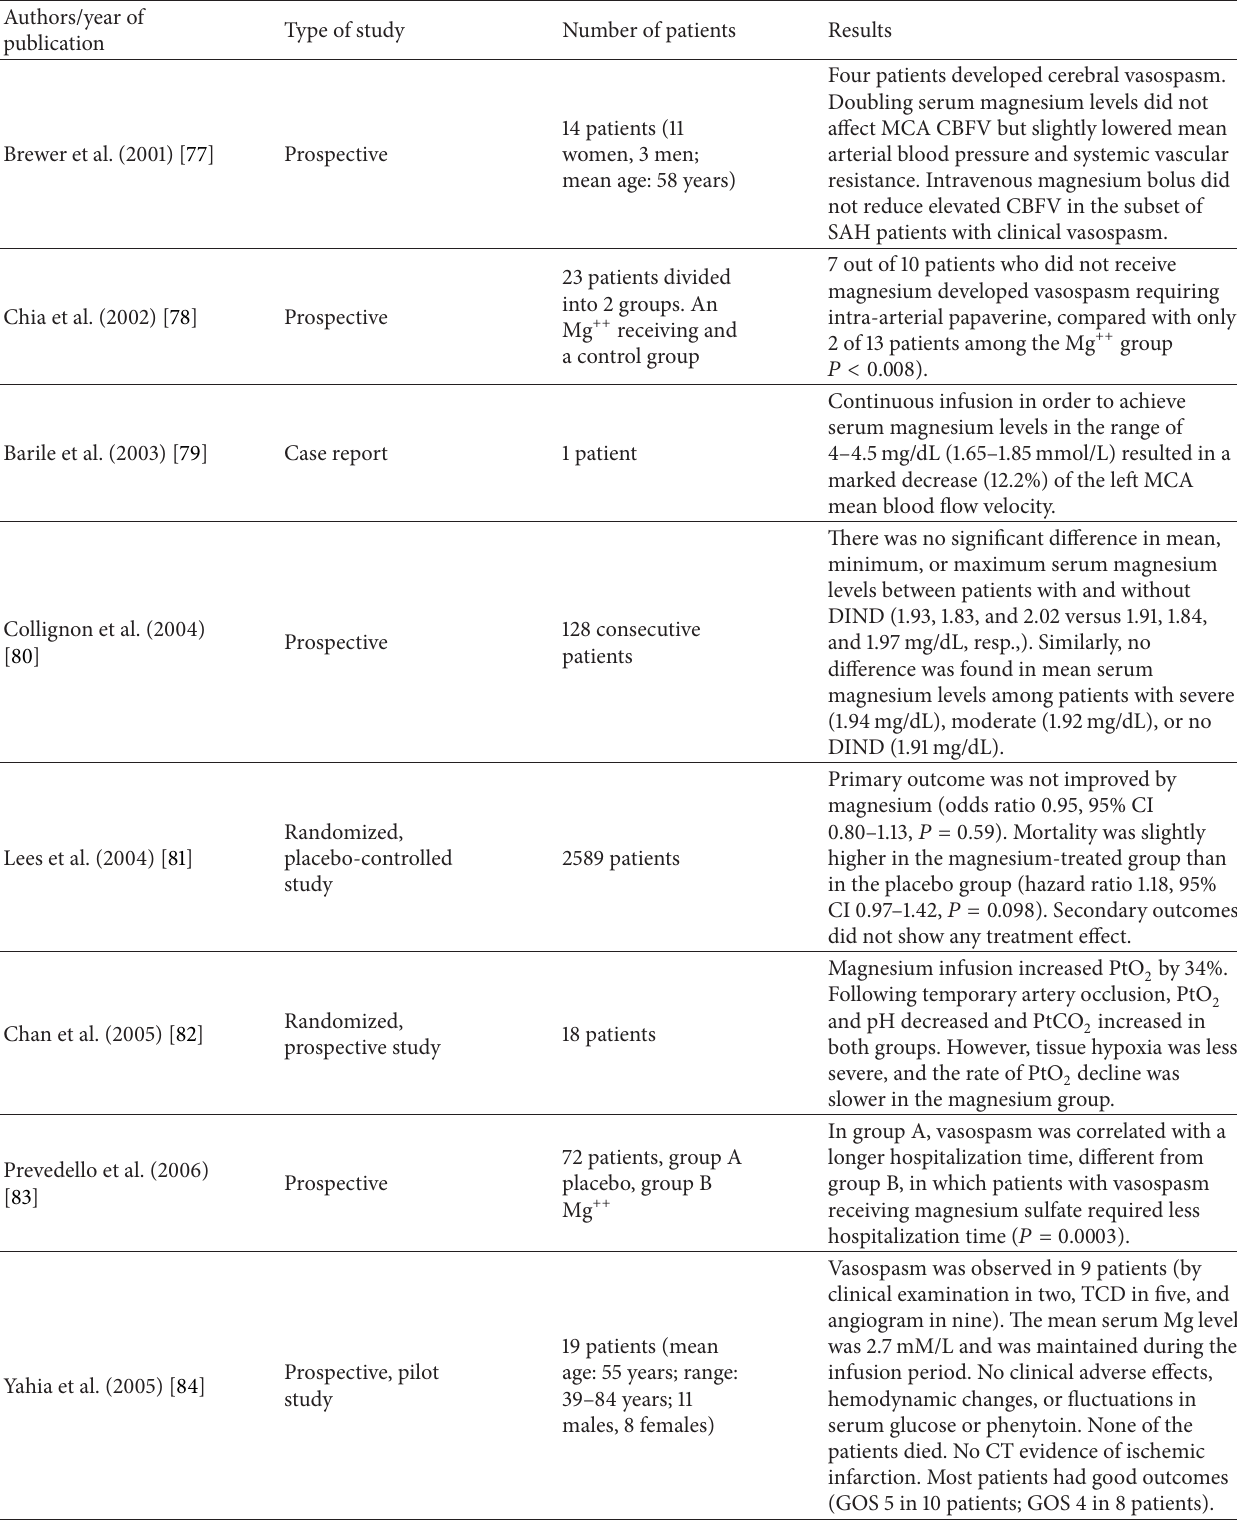
Table 2: Summary of clinical data regarding magnesium sulphate in managing cerebral